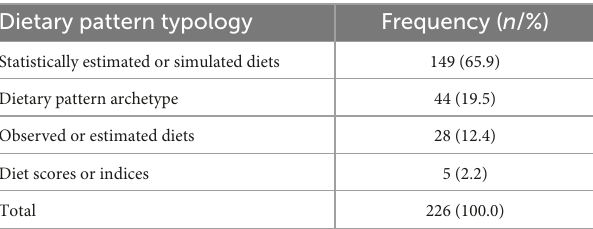
TABLE 2 Tabulation of dietary pattern typologies included in the final set of studies.